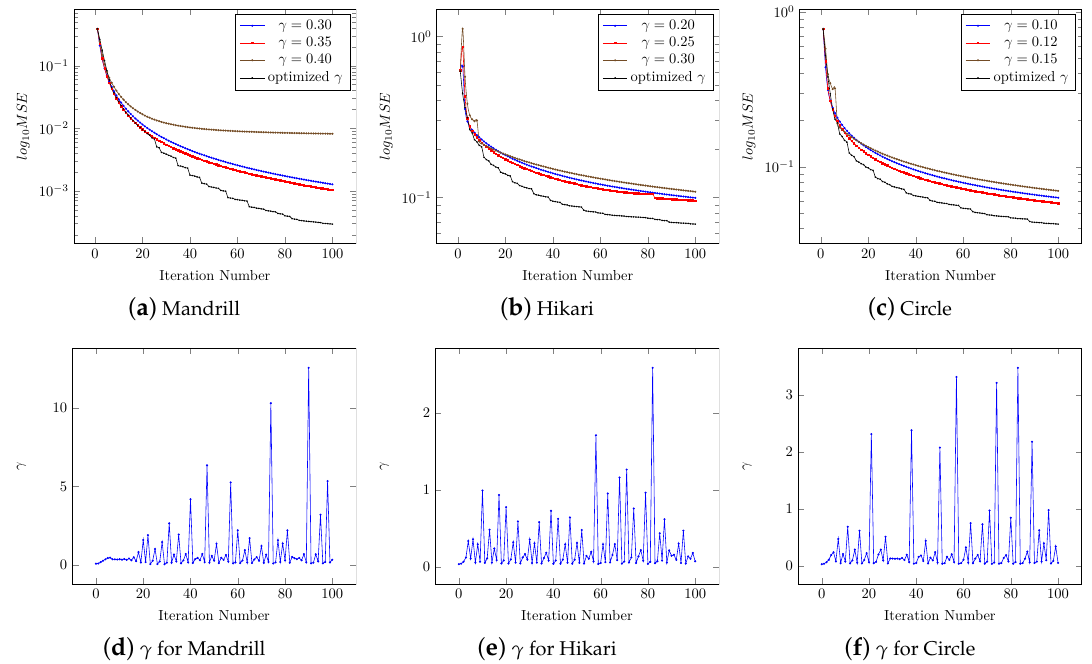
Figure 9. MSEs obtained for constant and optimized step length coefficients: ( a ) mandrill, ( b ) hikari, and ( c ) circle. ( d – f ) show the changes of the coefficient γ corresponding to ( a – c